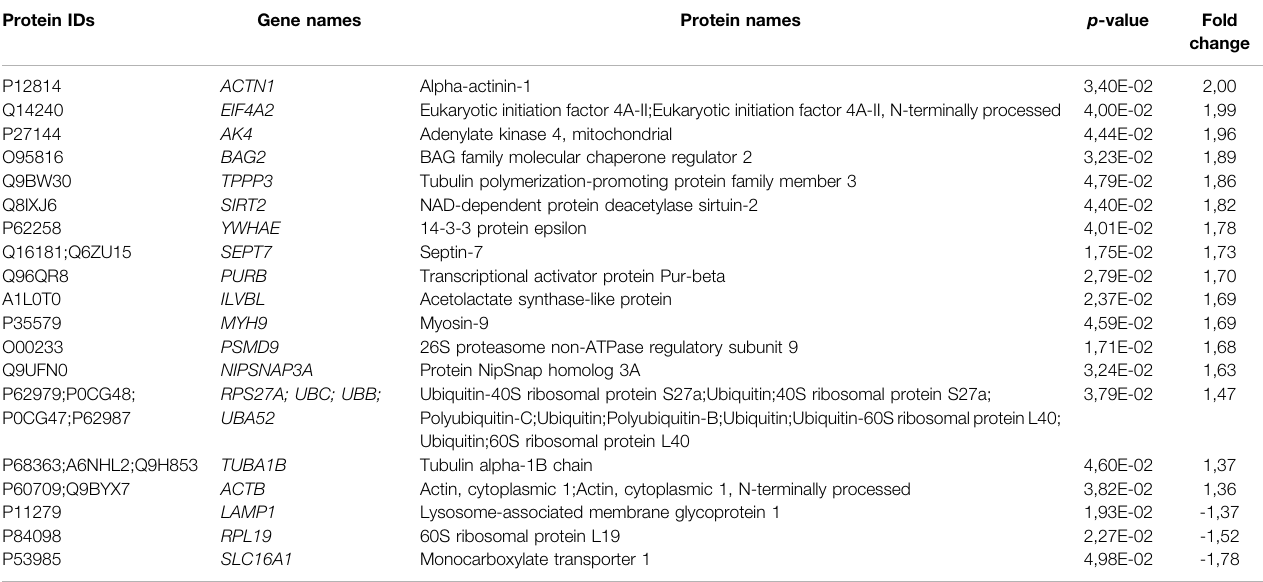
TABLE 1 | ( Continued ) Differentially expressed proteins identi fi ed in human skeletal muscle cells following electrical pulse stimulation (EPS) protocol 1 for 24